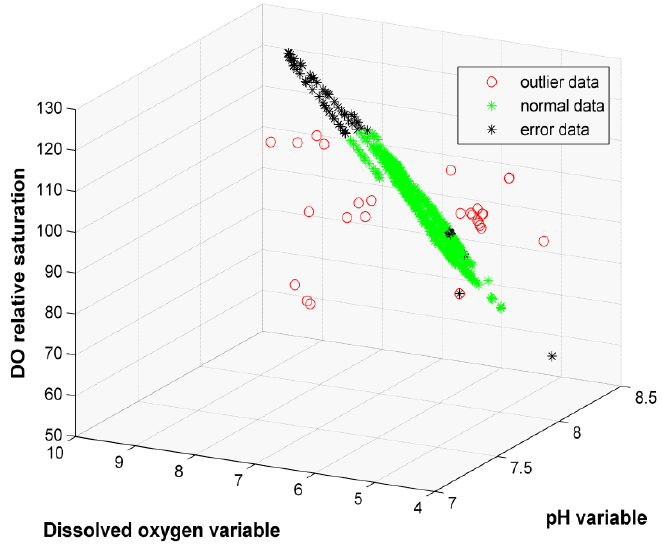
Figure 4. Detection results of the water quality dataset in the testing process.